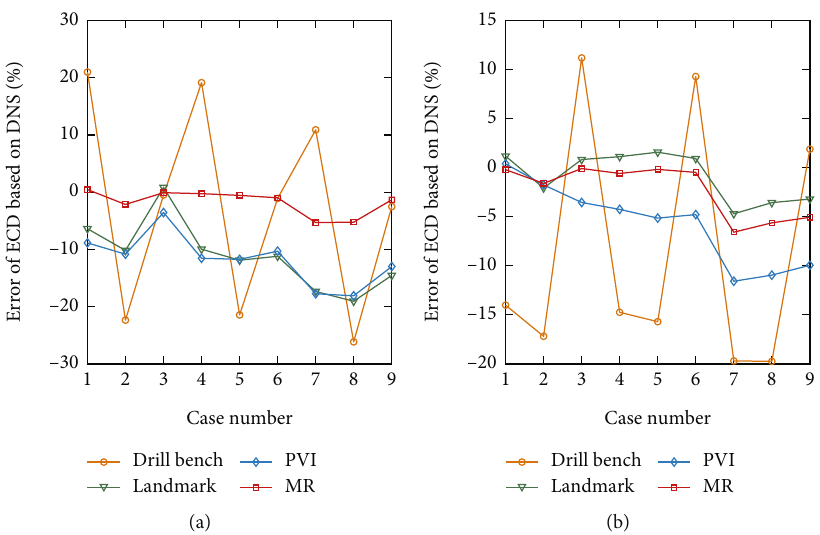
Figure 8: Change of fl ow speed in the junction region of two sections with di ff erent radial sizes: (a) contour of fl ow speed; (b) the corresponding vector